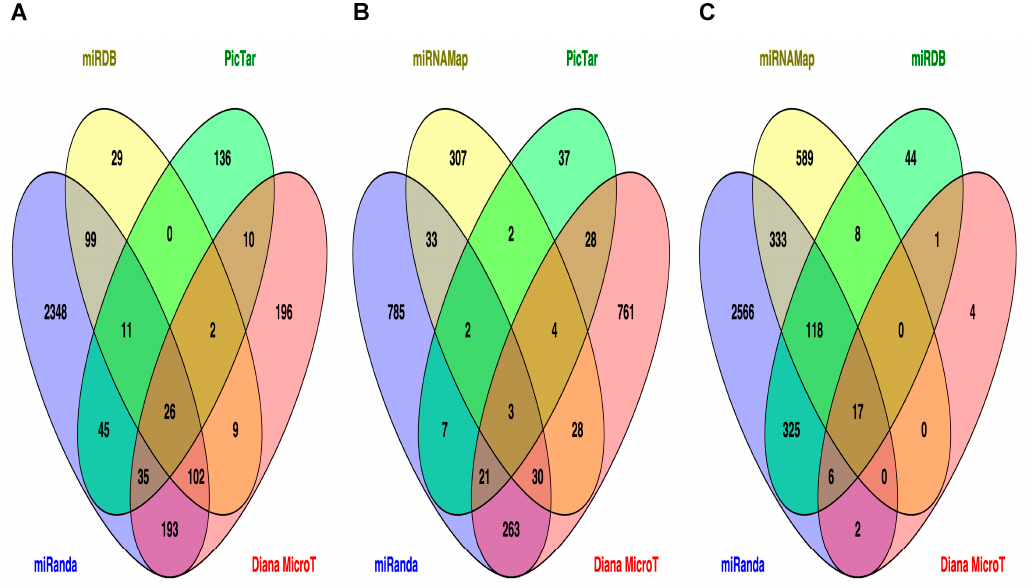
Figure 3. Venn diagrams illustrating the bioinformatics analysis of target genes for miR-33b ( A ), miR-375 ( B ) and miR-454-3p ( C ). For each miRNA, at least four public online database algorithms were used to identify target mRNAs. The overlap shows the number of targets shared by the algorithms, increasing the number of candidate genes with strong likelihood to be experimentally validated. Table 1. Target genes of miR-33b by Kyoto Encyclopedia of Genes and Genomas (KEGG) pathway analysis.